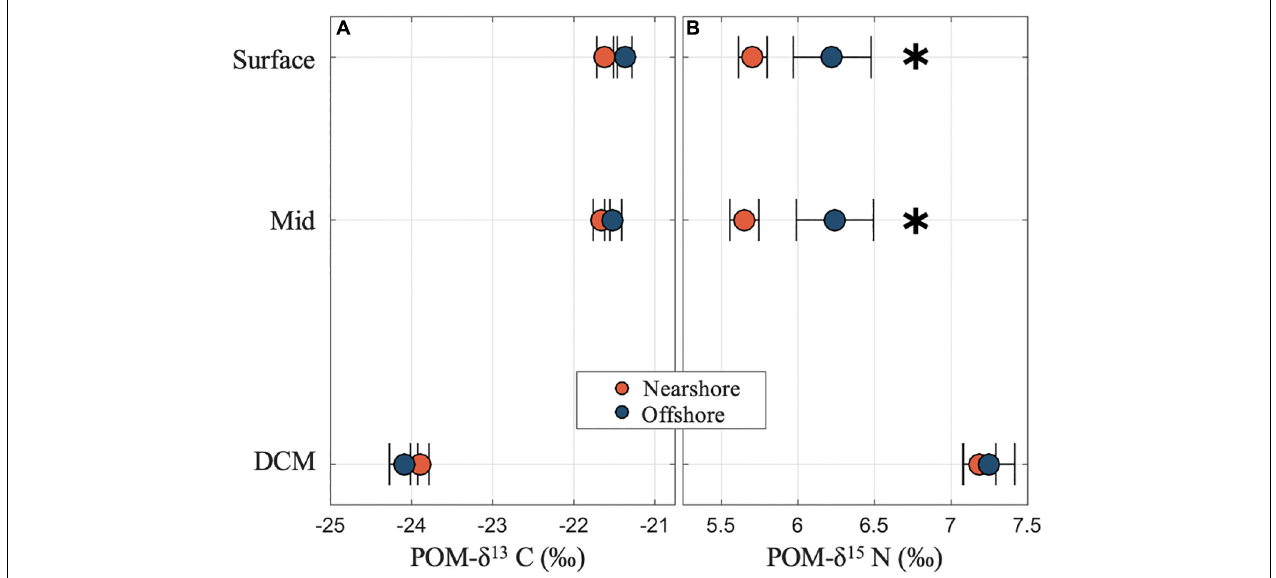
FIGURE 3 | Carbon and nitrogen isotope compositions of POM in surface, mid and deep chlorophyll maxima (DCM) layers near and offshore from Mo’orea showing ) for POM in the DCM relative to the surface layers and (B) significantly elevated nitrogen isotopes (POM- δ 15 N in (A) depleted carbon isotopes (POM- δ 13 C in the DCM and at stations offshore relative to near the island. Asterisks denote significant differences between nearshore and offshore samples ( p values < (cid:104)